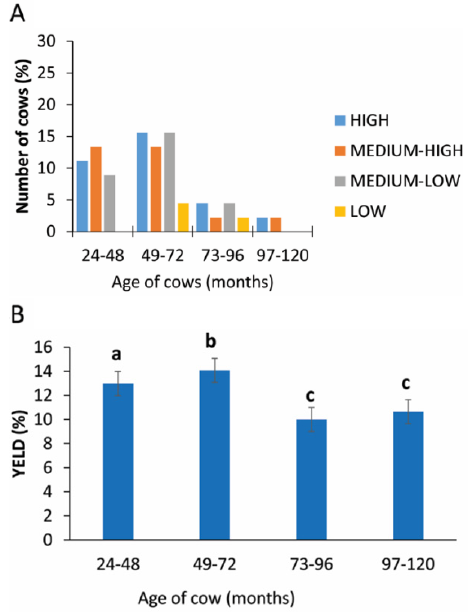
Figure 5. PRP yield considering the age of cow. ( A ) Distribution (%) of cows in different PRP yield classes considering the different age classes. ( B ) Comparison of PRP yield in different age classes. Values are expressed as means and standard deviations. Different letters represent statistically significant differences.